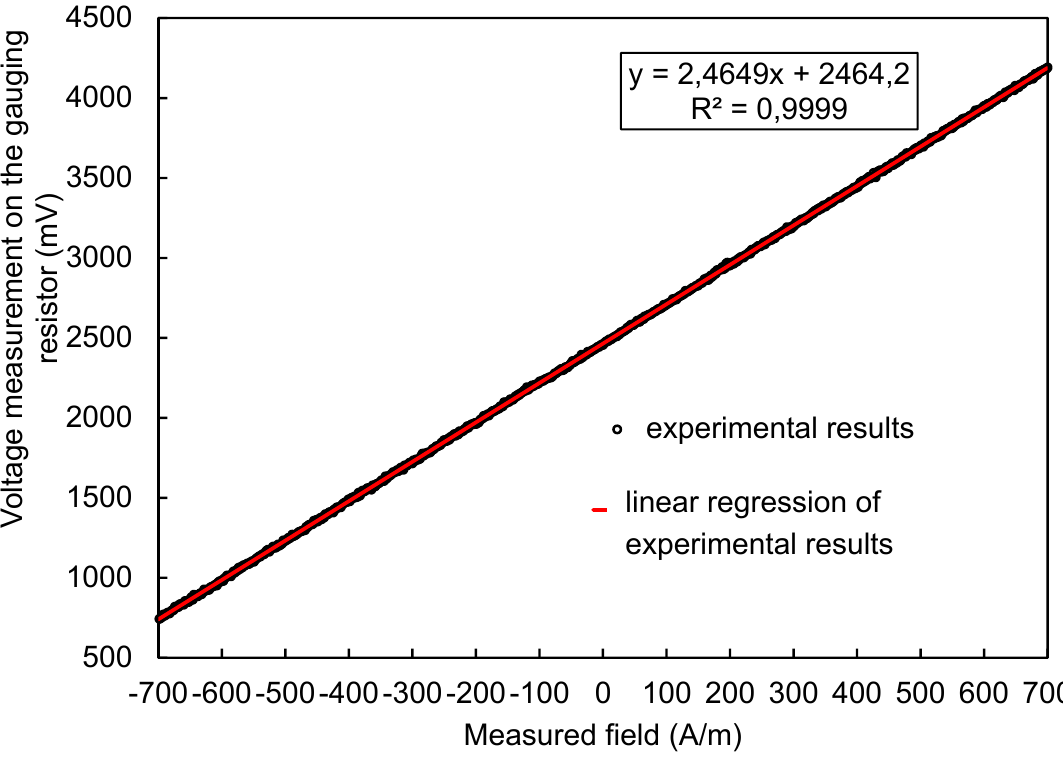
Figure 11. Processing characteristics of the developed sensor.